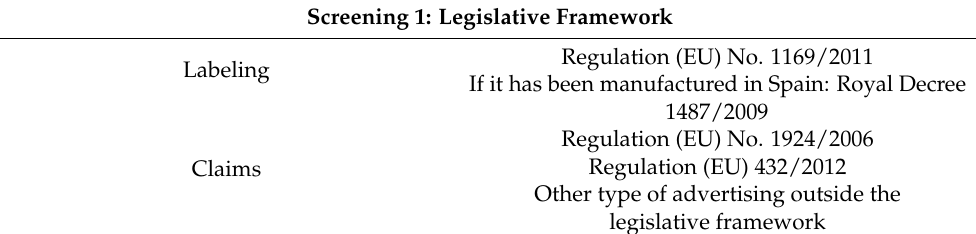
Screening 2: Protein quality